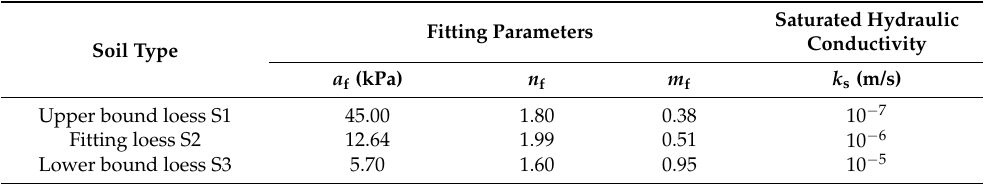
Table 3. Fitting parameters of SWCC and saturated hydraulic conductivity.